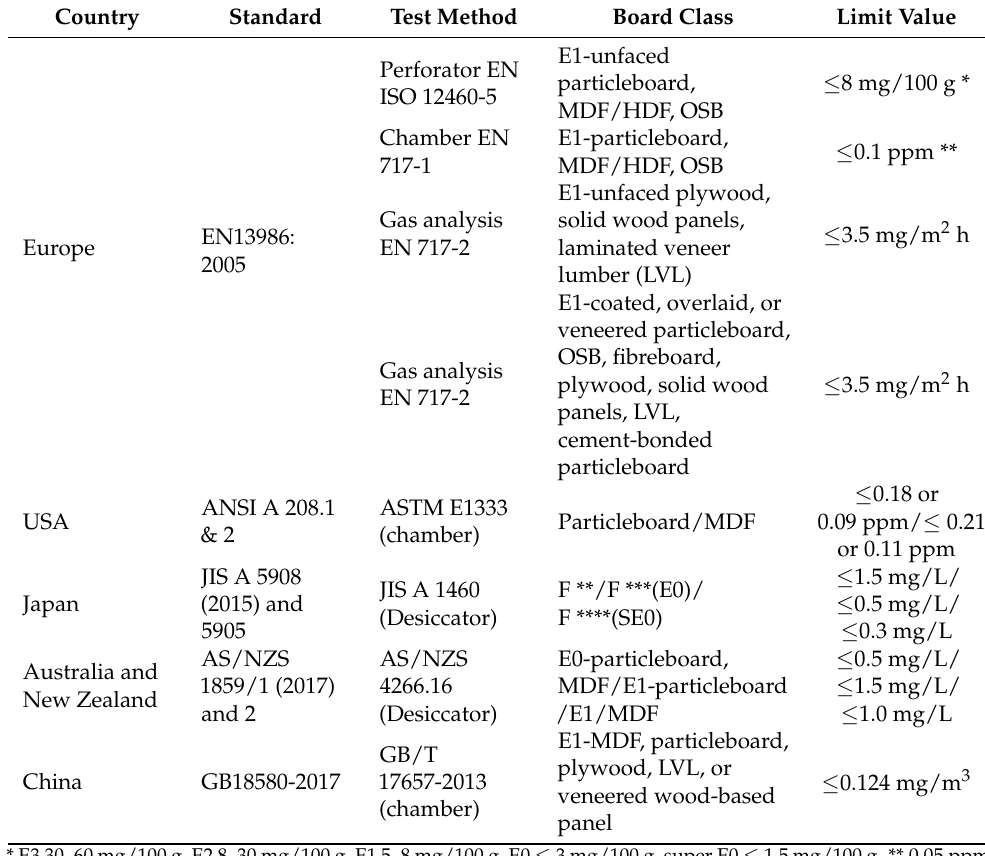
Table 1. Formaldehyde emission standards for wood-based panels in Europe, the USA, Japan, Australia, and